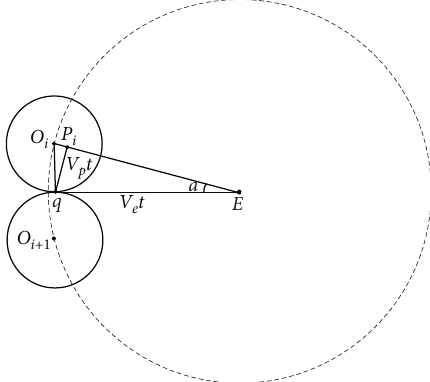
Figure 2: Schematic of the Apollonius